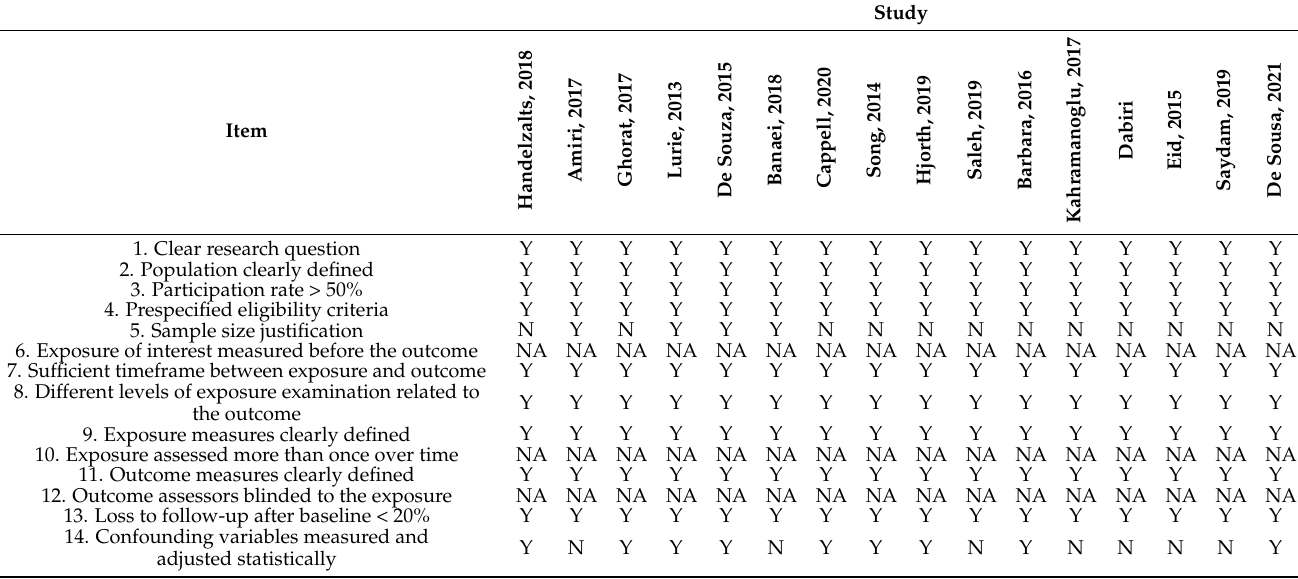
Table 2. Quality assessment of the included studies based on the Quality Assessment Tool for Observational Cohort and Cross-Sectional